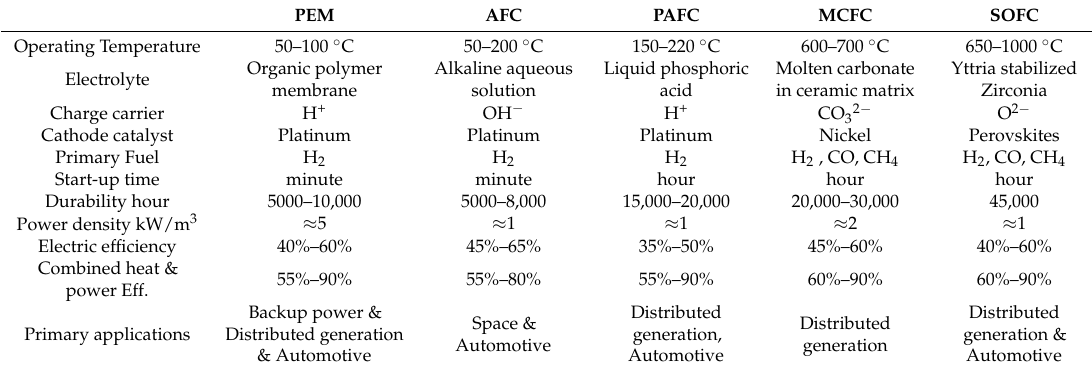
Table 2. Tested and performing fuel-cells types that provide energy services to the electric grid, off-grid and automotive power (References